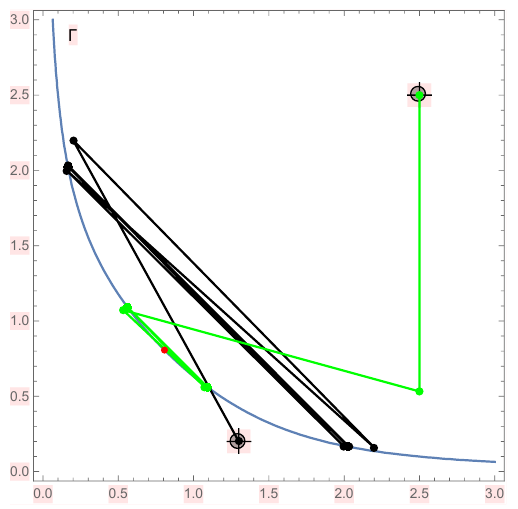
Figure 1. Visualization of Conjecture 3 with A = 1, F = 0.4 and initial conditions ( x − 1 , x 0 ) = ( 1.3,0.2 ) —black, ( x − ) = ( 2.5,2.5 ) 1 , x 0